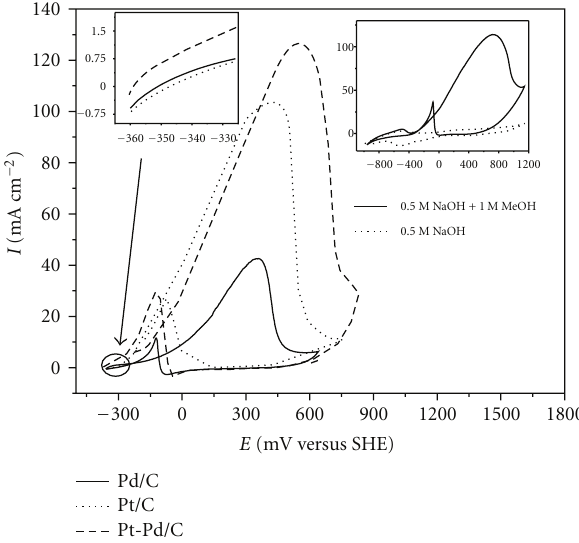
Figure 4: Cyclic voltammograms for methanol oxidation on Pd/C, Pt/C, and Pt-Pd/C electrodes in a mixture of 0.5 MNaOH and 1.0M methanol at 25 ◦ C and sweep rate of 50 mVs − 1 ; inset: cyclic voltammograms of Pt-Pd/C electrode in 0.5MNaOH with and without 1.0 M methanol at identical